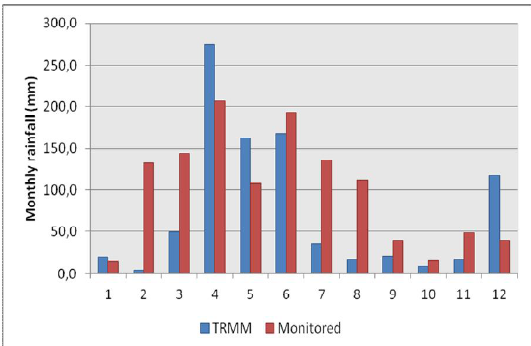
Figure 10. Monthly rainfall – TRMM x monitored data (year